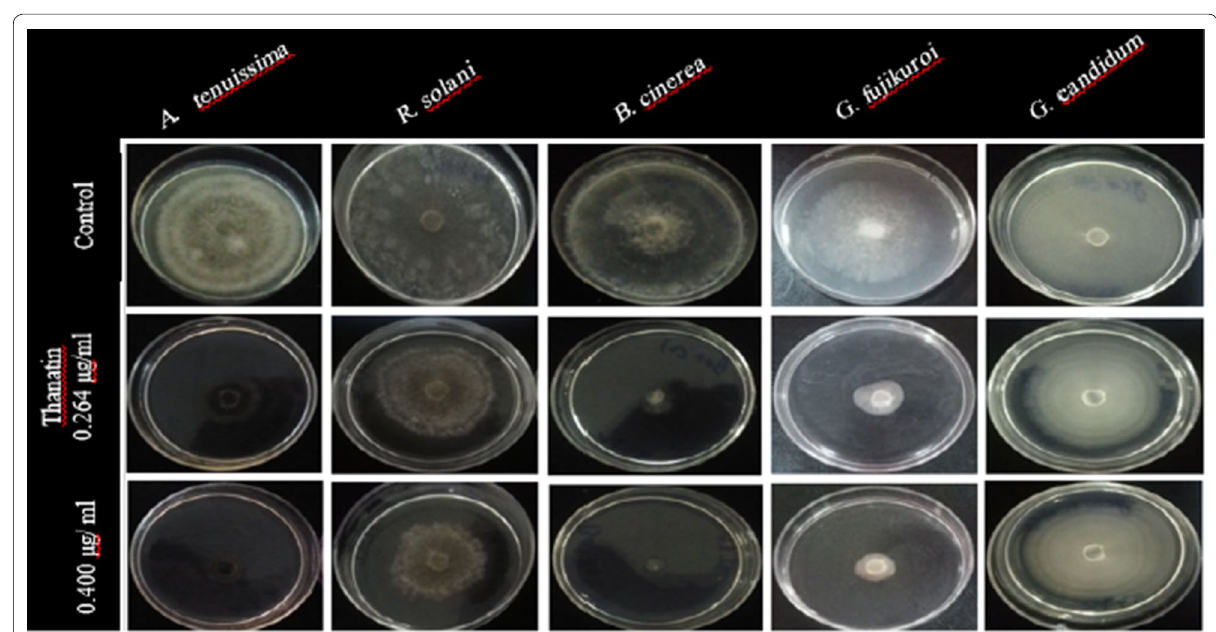
Fig. 6 Antifungal effects of recombinant thanatin against different plant pathogenic fungi under in vitro condition